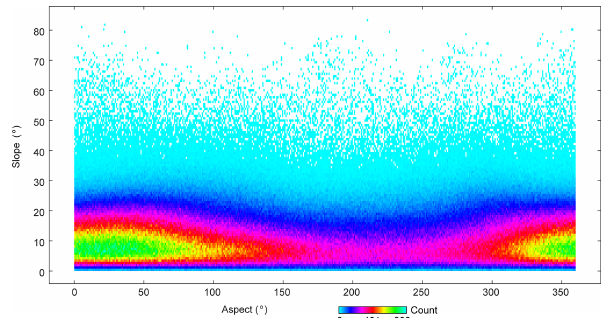
Figure 12. Distribution of measurements in different aspects against the